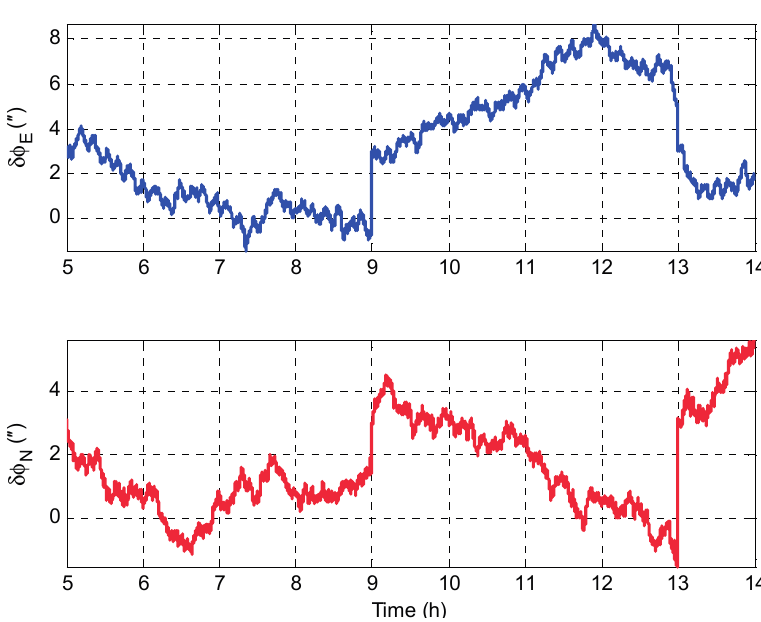
Figure 6. Attitude errors of the LGU.